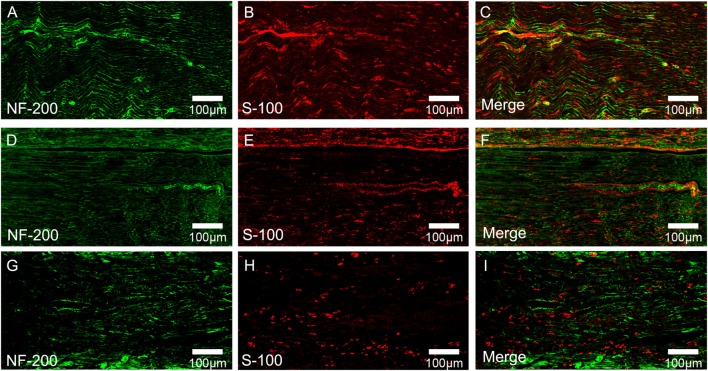
Double-immunohistochemical staining for S-100 and NF200 in each group. The representative images of regenerated nerves in the midst of conduit in the DPEMF group (A–C), NPEMF group (D–F), and CF group (G–I), postoperatively.